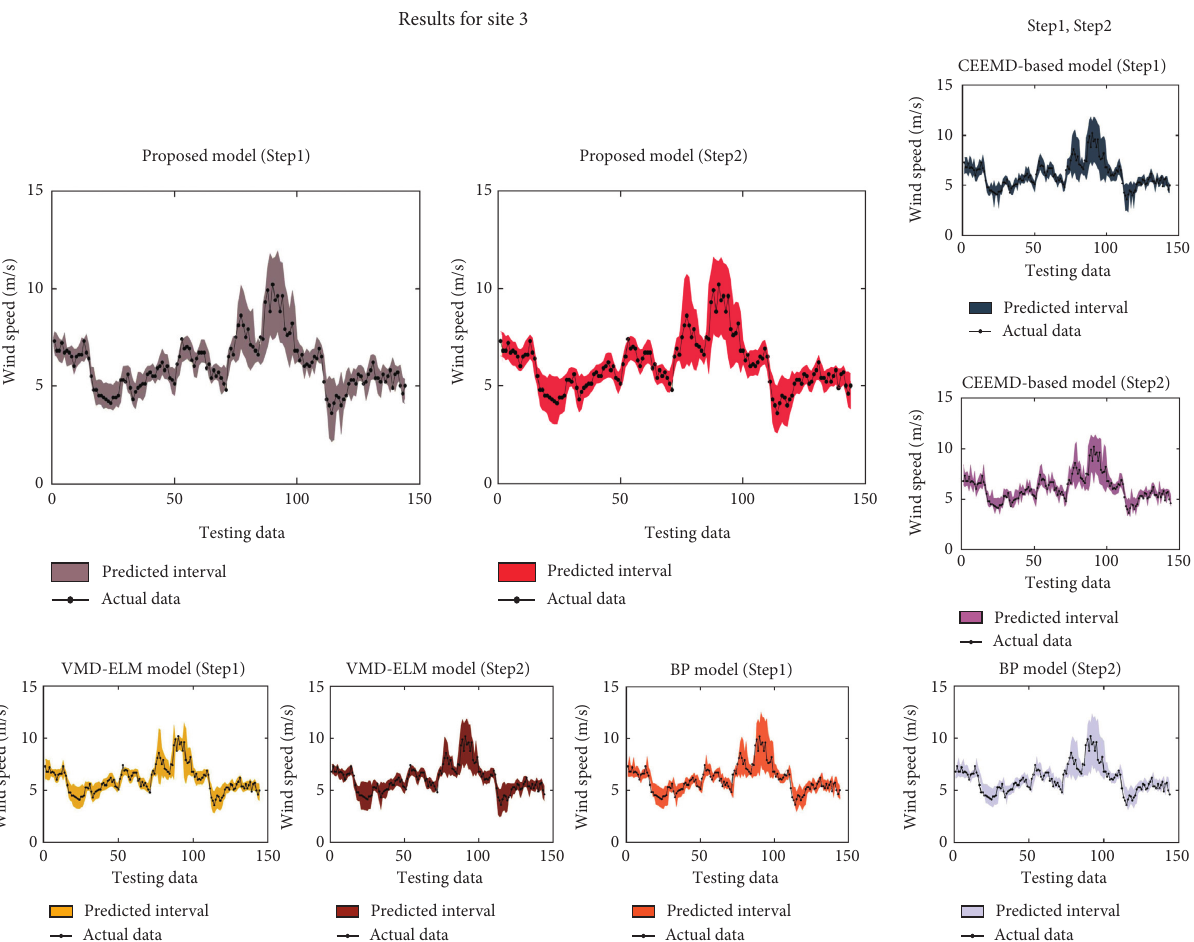
Figure 5: The final interval results of some models in multistep prediction in experiment III for dataset 3. The figure shows the interval forecasting results of the proposed model, VMD-ELM model, CEEMD-based model, and BP single model, respectively. Besides, the figure shows the relationship between the interval prediction band and the real